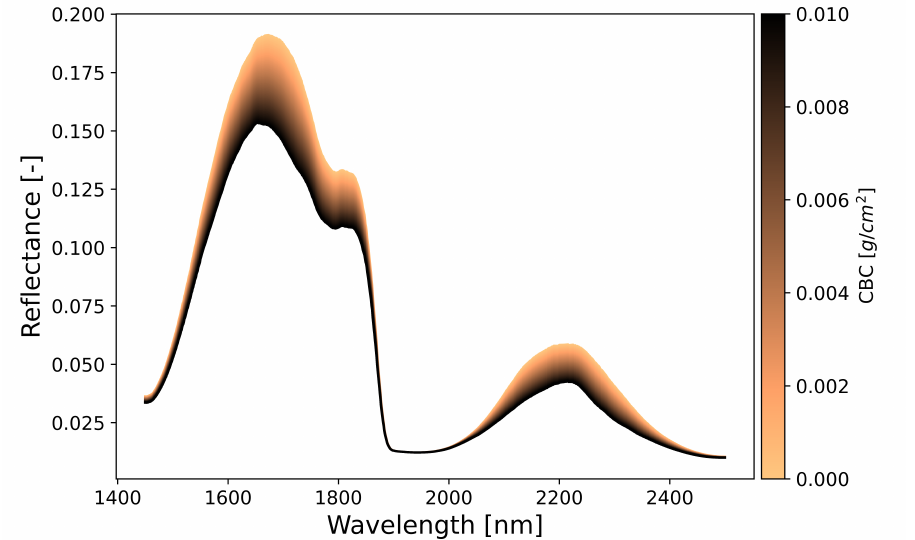
Figure 2. Local sensitivity analysis of carbon-based constituents in the SWIR domain using the Interactive Visualization of Vegetation Reflectance Models (IVVRM) tool of the EnMAP-Box Agri- Apps. CBC was ranged between 0–0.01 and all other variables were fixed to standard